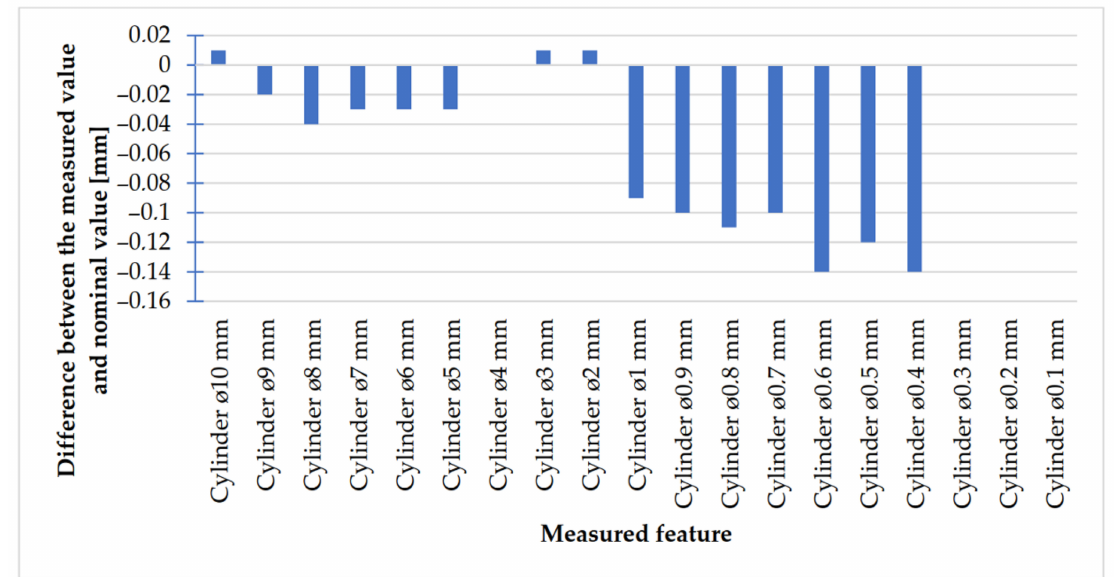
Figure 30. Deviation analysis for cylinders made in DMLS technology.